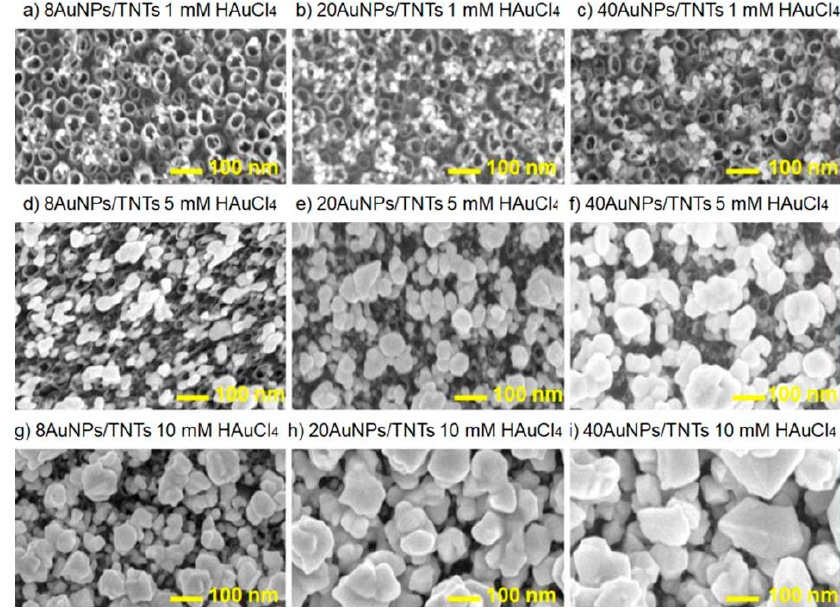
Figure 5. SEM images of annealed TNT arrays after deposition of AuNPs using CV method carried out for different number of cycles 8, 20, 40 (in columns) and in different concentration of HAuCl 4 solution: ( a – c ) 1 mM, ( d – f ) 5 mM, ( g – i ) 10 mM (in line).